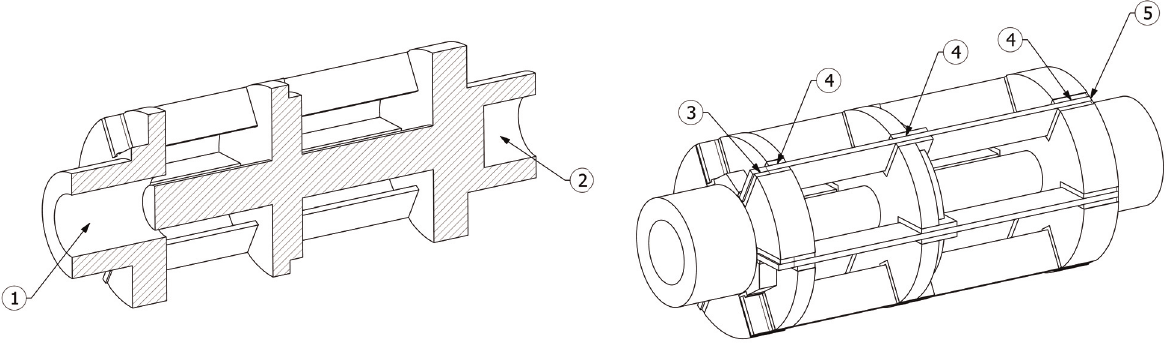
Fig. 3. Forces and boundary conditions in the simplified coupling. 1. Torque load. 2. Fixed constraint. 3. Rigid connection. 4. Non-linear contact. 5. Springs with small